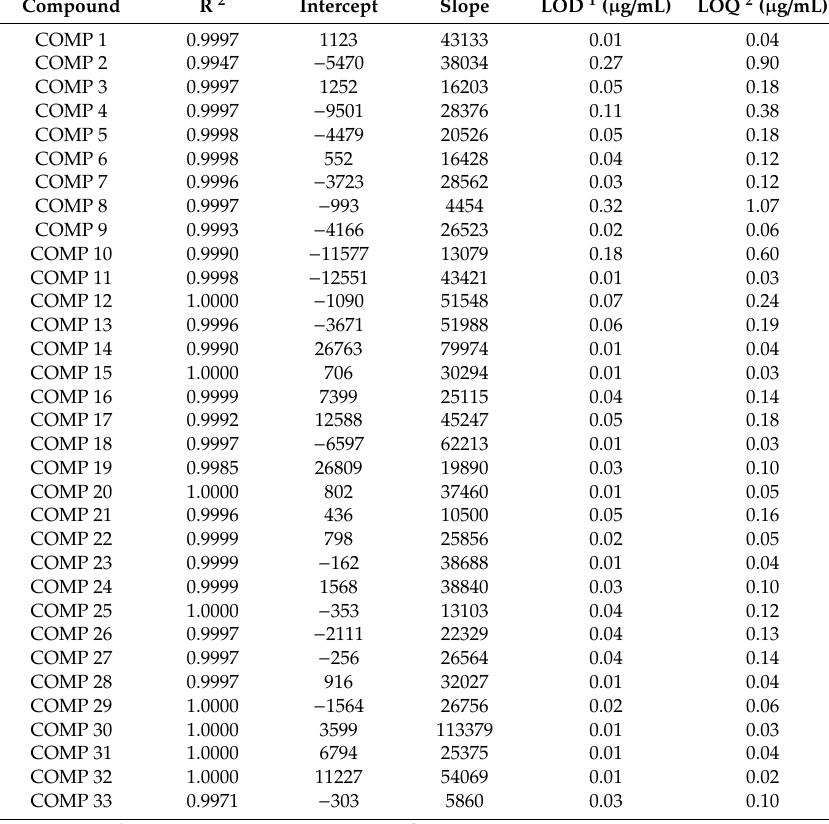
Table 6. Analytical figures of merit of HPLC-UV and LC-MS